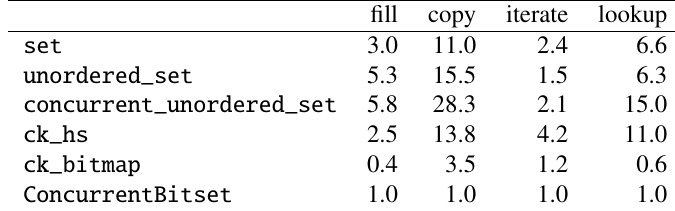
Table 1. Single-threaded timing comparisons between ConcurrentBitset and alternate implementations. Smaller is better, and each (dimensionless) column is normalized to